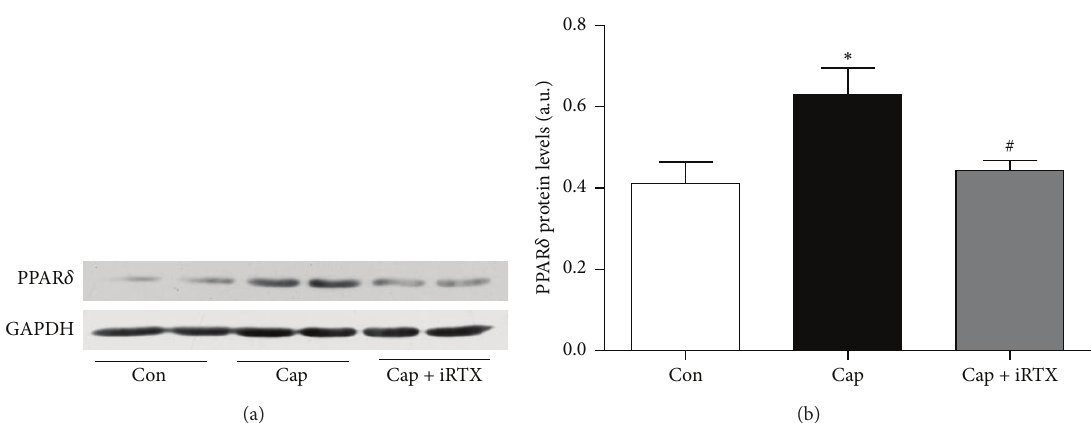
Figure 5: TRPV1 activation increases PPAR- 𝛿 expression in H9c2 cells. Immunoblotting of PPAR- 𝛿 was performed in H9c2 cardiomyocytes stimulated with capsaicin (1 𝜇 mol/L) in the presence or absence of iRTX (1 𝜇 mol/L) for 24 h. Data are means ± SEM from 3 separate experiments. ∗ 𝑃 < 0.05 versus control; # 𝑃 < 0.05 versus